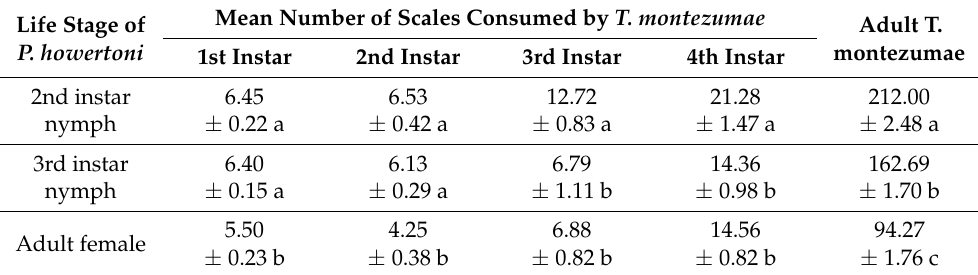
Table 1. Feeding preferences (mean number prey ± SE) of instars of T. montezumae on different stages of P. howertoni under laboratory